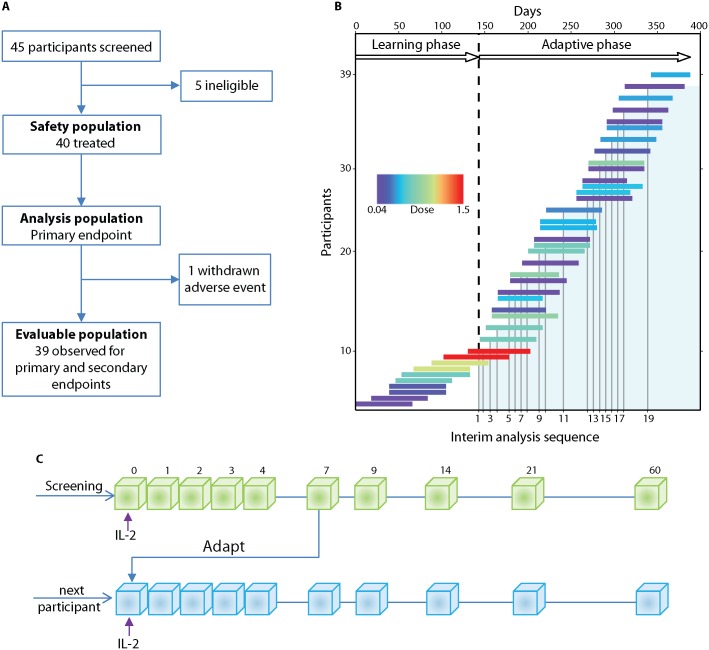
DILT1D study profile and adaptive design.(A) Flow chart showing the allocation of participants to the three predefined study populations: evaluable, safety, and analysis. (B) The study was conducted in two phases, a learning phase (140 d) and an adaptive phase (240 d). Individual participants are represented by a horizontal line, the length corresponding to the time from treatment until their final visit. In the learning phase, the first ten participants received a 0.04 × 106, 0.16 × 106, 0.60 × 106, 1.00 × 106, or 1.50 × 106 IU/m2 dose of aldesleukin (colour represents dose allocated) in ascending order, with each dose being administered to two participants before escalation. In the adaptive phase, the DDC (S3 Materials) met on 19 occasions to review the interim safety data and allocate doses based on the analysis of the accumulated Treg data (shaded area) from all treated participants at that time. (C) Schematic of the study design illustrating that each participant who passed screening was administered a single dose of aldesleukin and followed for 60 d. During the adaptive phase, Treg data for every participant up to day 7 was included in an interim analysis and then further doses were allocated to the next participants. Treg, regulatory T cell; DDC, Dose Determining Committee.